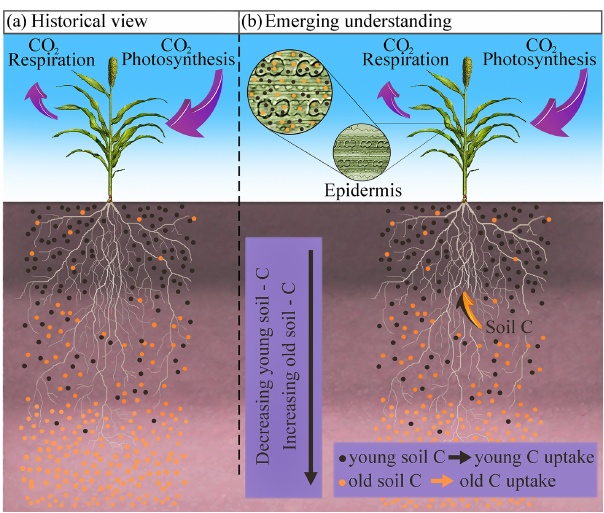
Figure 1. Sketch of (a) the conventional hypothesis of plant C oc- clusion during silica precipitation based solely on atmospheric CO 2 as a source, and (b) the emerging hypothesis of a dual origin (atmo- spheric CO 2 and SOM) for plant C (and phytC). Young and old soil C distributed in leaf epidermis (green tissue) and phytoliths (illus- trated by the bilobate type shape outlined in black) are represented by black and orange dots, respectively, in the microscope